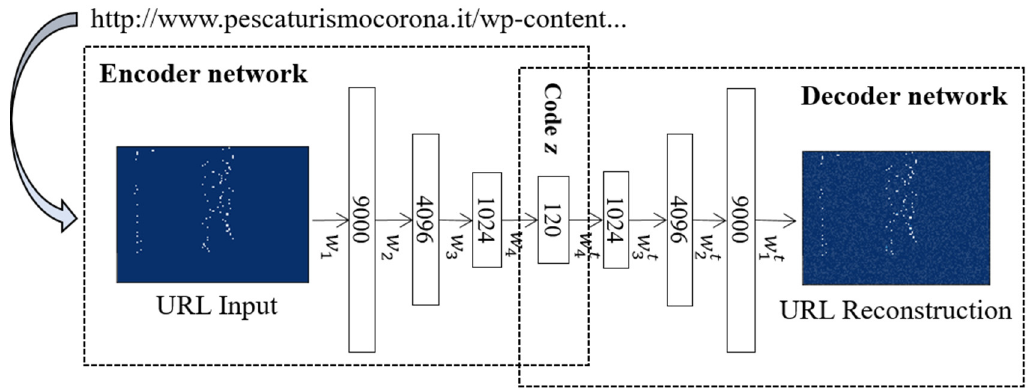
Figure 5. An illustration of autoencoder that reconstructs a URL image expressed as a vector of (𝑙𝑒𝑛𝑔𝑡ℎ,𝑑𝑖𝑐𝑡𝑖𝑜𝑛𝑎𝑟𝑦 𝑠𝑖𝑧𝑒) . The URL image is encoded as a 120-dimensional vector in the hidden layer.